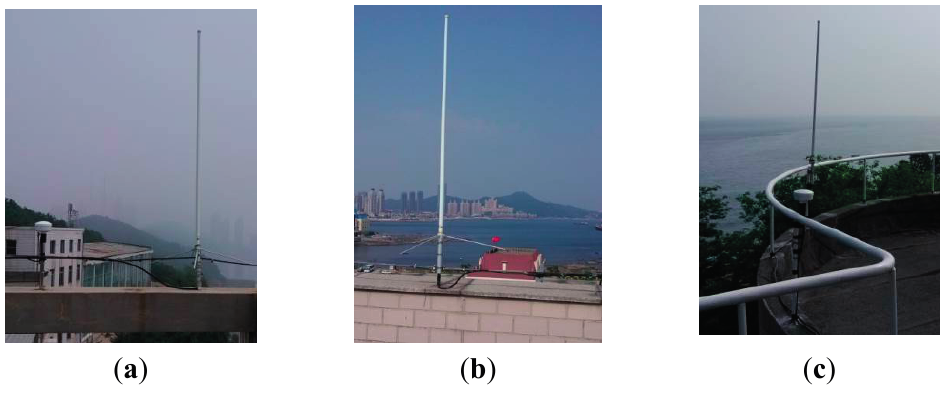
Figure 11. Working environment of the base stations: ( a ) Lingjing; ( b ) Heishijiao; ( c )